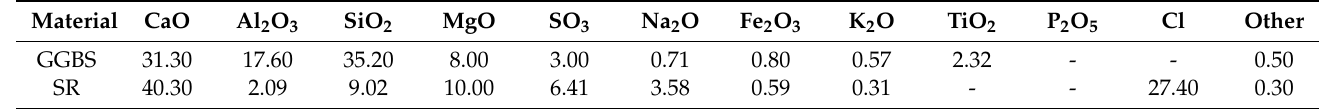
Table 1. Chemical constituents of raw materials (wt/%), data from